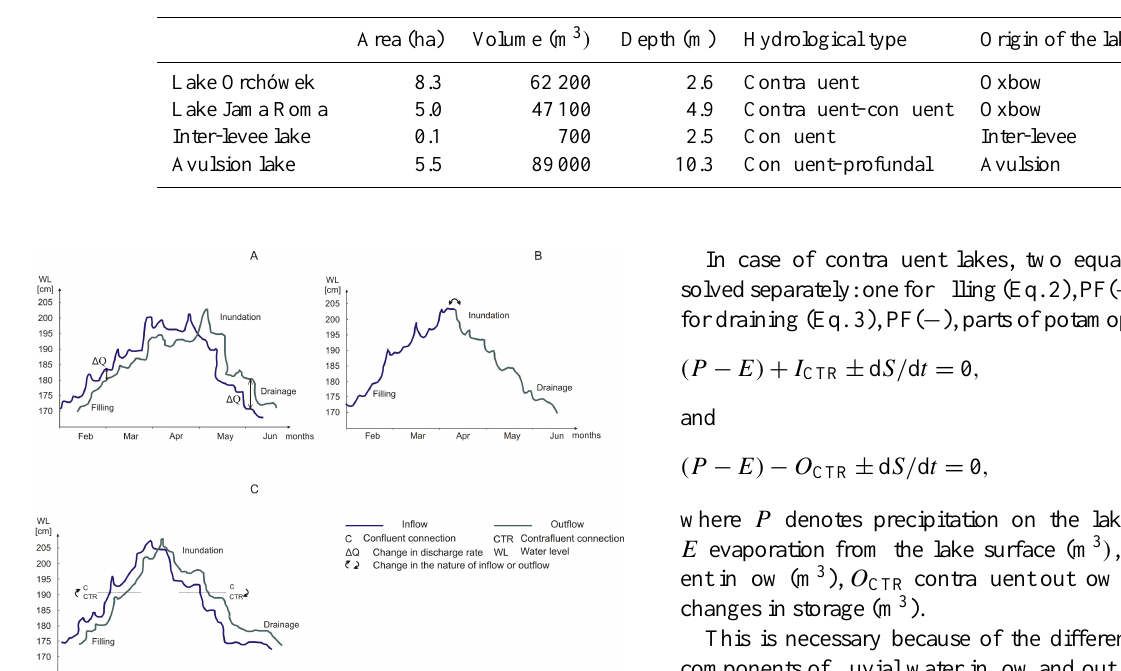
western border of the study area was marked by the mor- phological edge of an older terrace, which was a noticeable terrain feature (Fig.